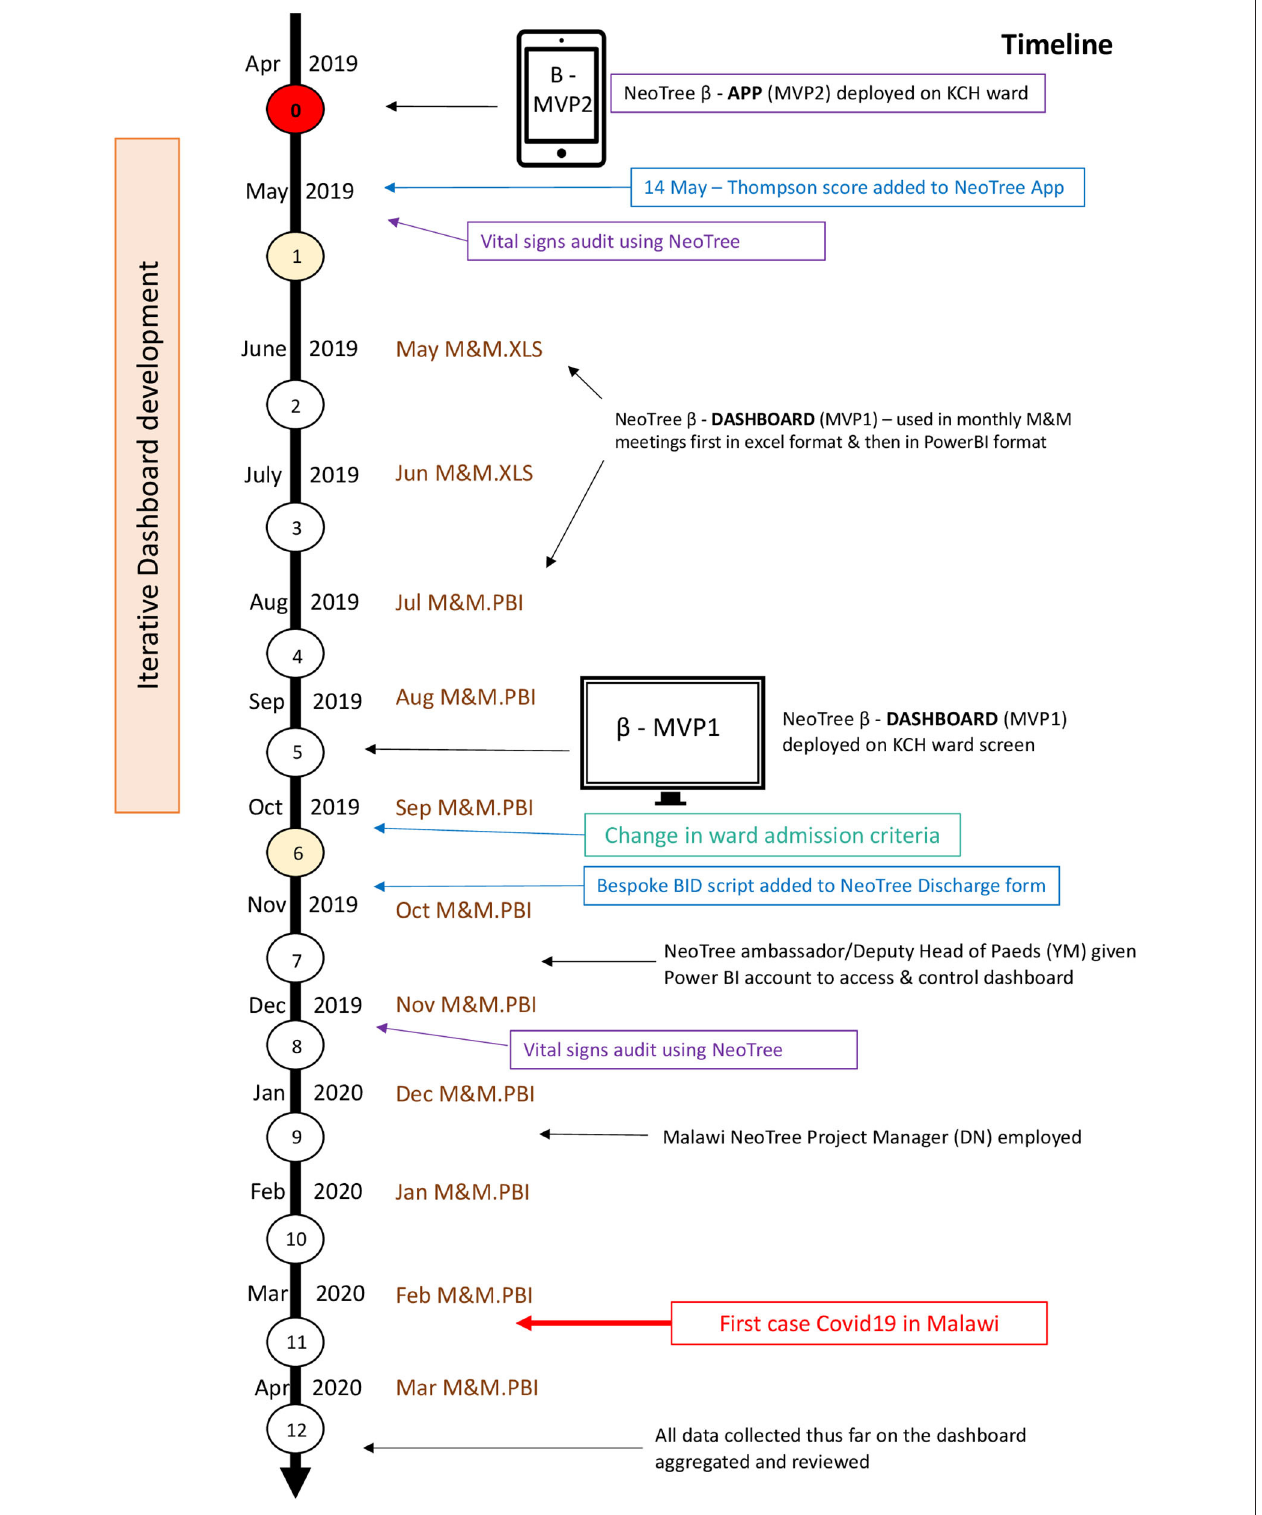
FIGURE 1 | The study timeline. MVP, minimum viable product; KCH, Kamuzu Central Hospital; M&M, morbidity and mortality; XLS, microsoft excel; PBI, microsoft power BI (buisiness intelligence).